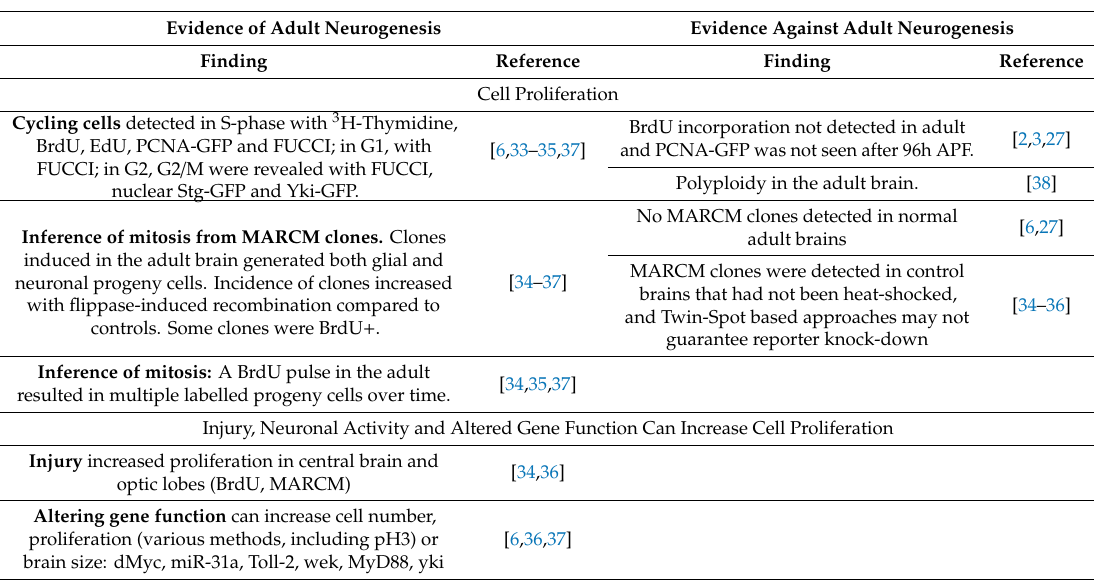
Table 1. Evidence for and against adult neurogenesis in Drosophila . Summary of findings reported in the review, that either support adult neurogenesis or not.